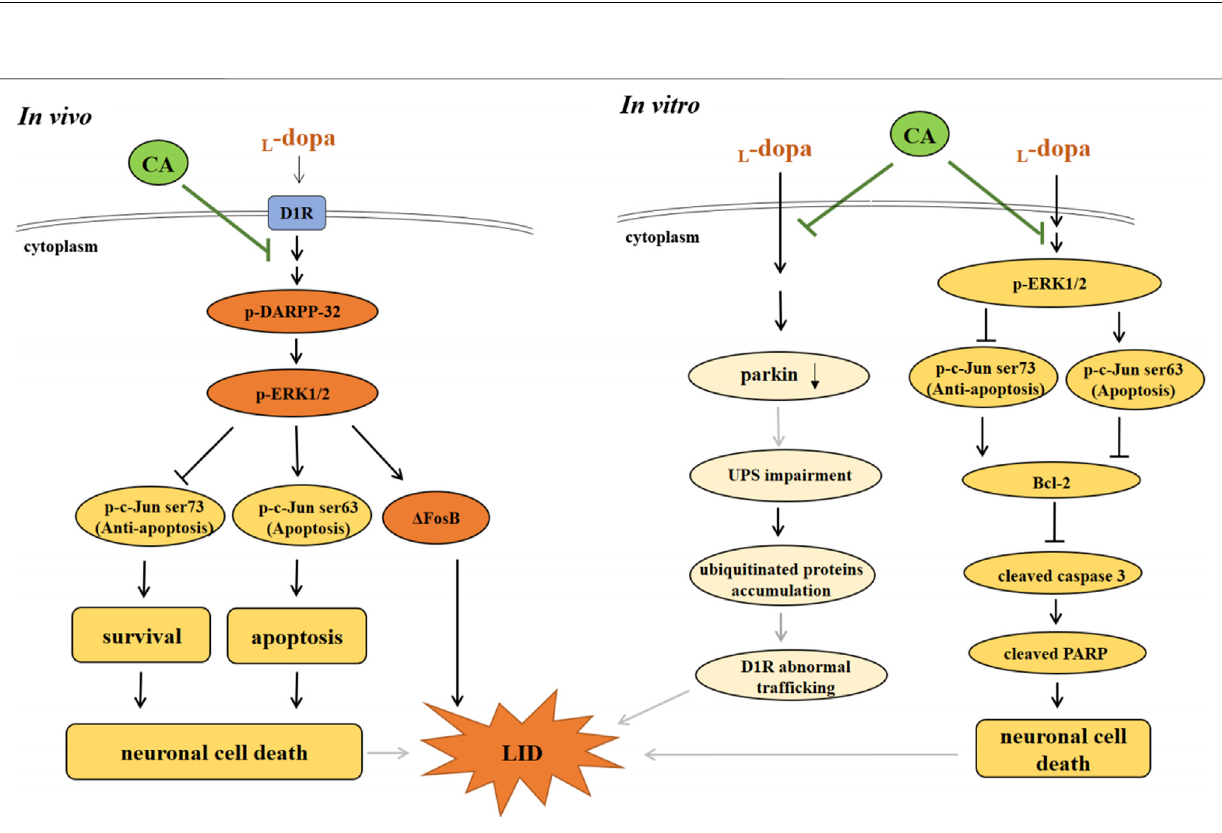
Frontiers in Pharmacology |